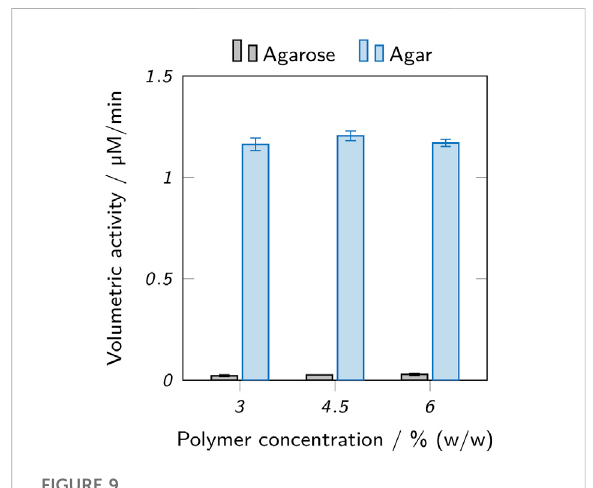
FIGURE 9 Activity assay of supernatants incubated with